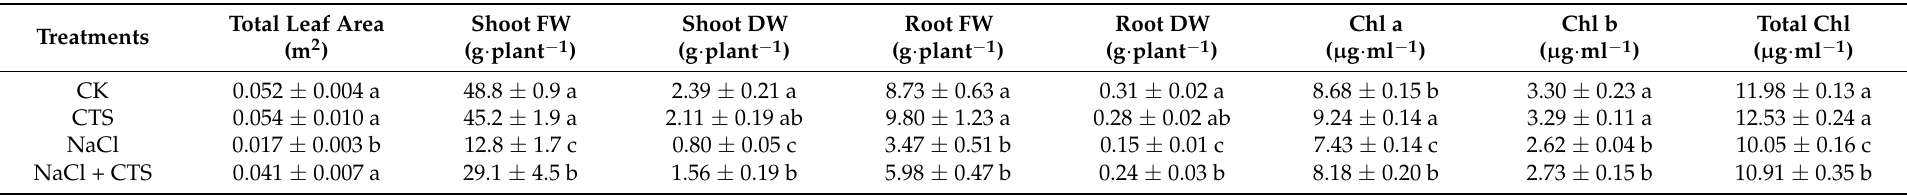
Table 1. Effects of chitosan (CTS) on total leaf area, shoot and root fresh weight, shoot and root dry weight, and leaf chlorophyll content of lettuce plants under salt stress.